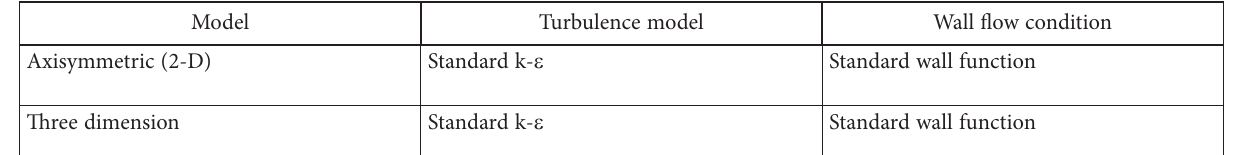
Table 2. Turbulence model features in the software